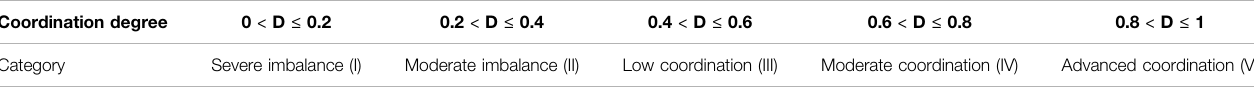
TABLE 2 | The classi fi cation of the coupling coordination degree of urbanization and eco-environment systems. Coordination